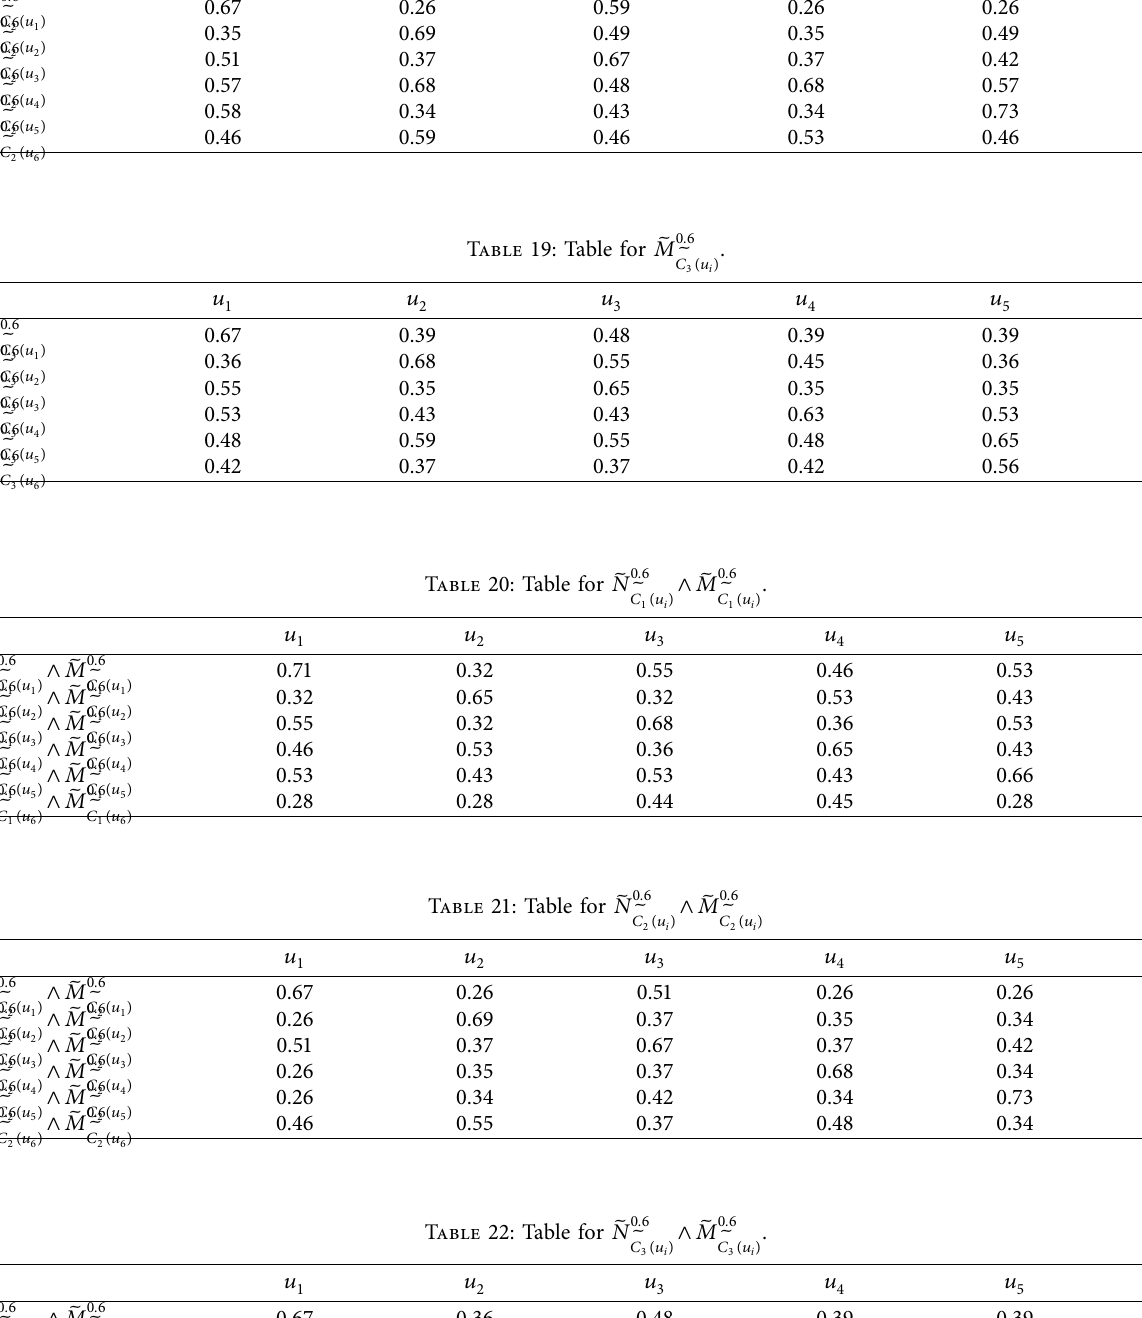
Table 22: Table for 􏽥 N 0 . 6 􏽥